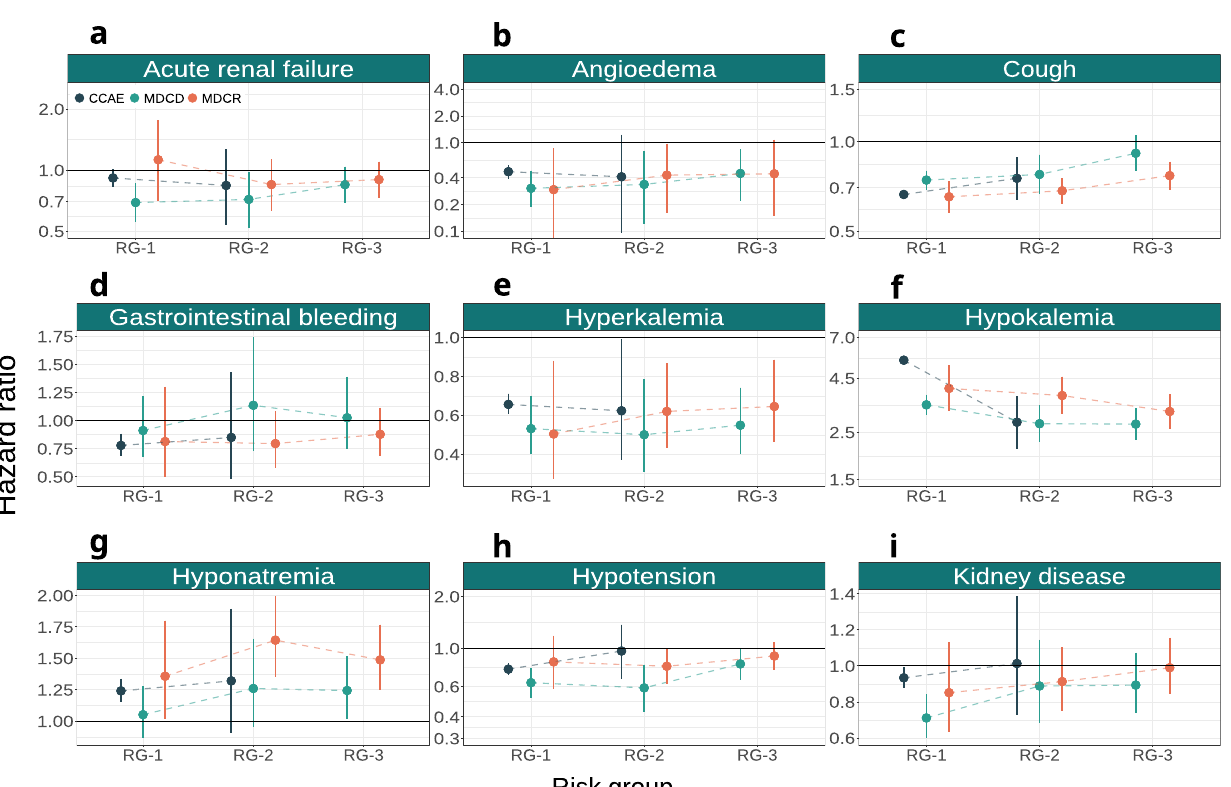
Fig. 7 Relative treatment effects for safety outcomes. Treatment effect heterogeneity for the safety outcomes on the relative scale (hazard ratios) of thiazide or thiazide-like diuretics compared to ACE inhibitors within strata of predicted acute MI risk. Panels present treatment effects on the relative scale for a acute renal failure, b angioedema, c cough, d gastrointestinal bleeding, e hyperkalemia, f hypokalemia, g hyponatremia, h hypotension, and i kidney disease within groups of predicted acute MI risk across all three databases. RG-1 represents the group of patients with acute MI risk below 1%; RG-2 represents the group of patients with acute MI risk between 1% and 1.5%; RG-3 represents the group of patients with acute MI risk larger than 1.5%. Hazard ratios estimated in CCAE, MDCD, and MDCR are represented by blue, green, and orange circles, respectively. Bars represent 95% con fi dence intervals. Values below 1 favor thiazide or thiazide-like diuretics, while values above 1 favor ACE